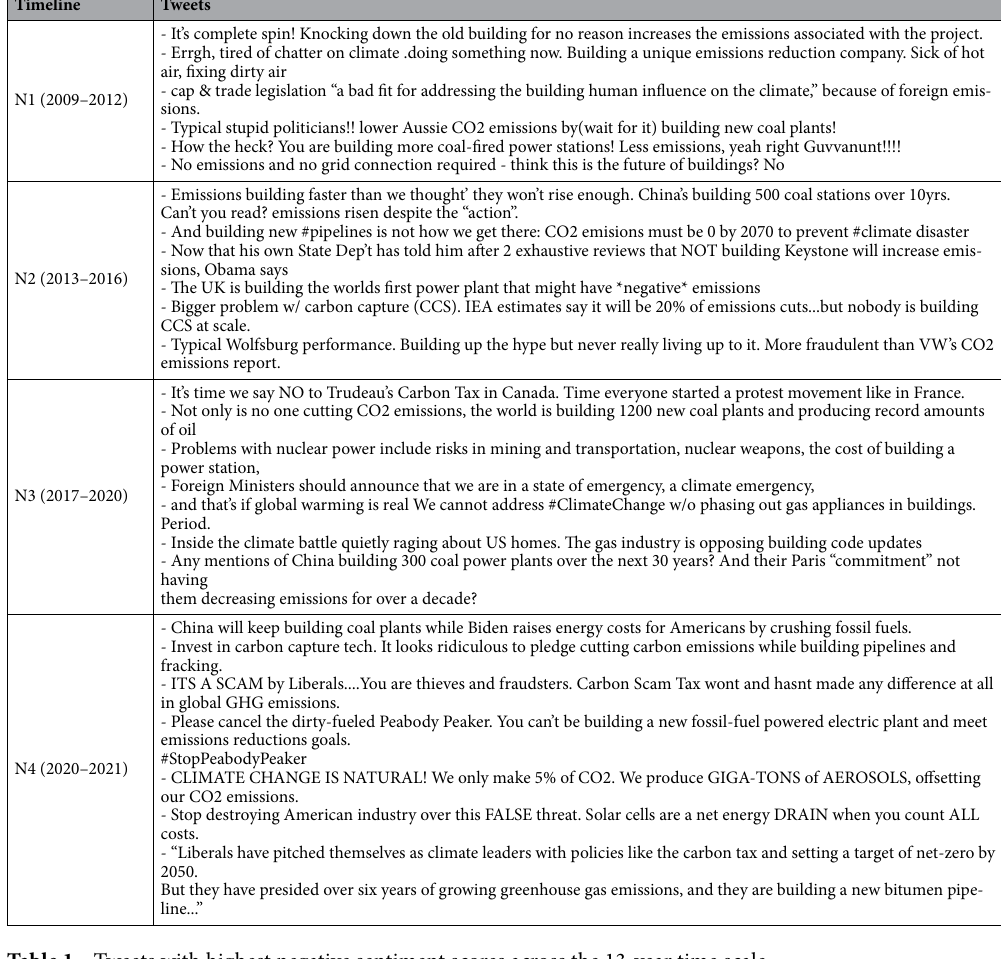
Table 1. Tweets with highest negative sentiment scores across the 13-year time